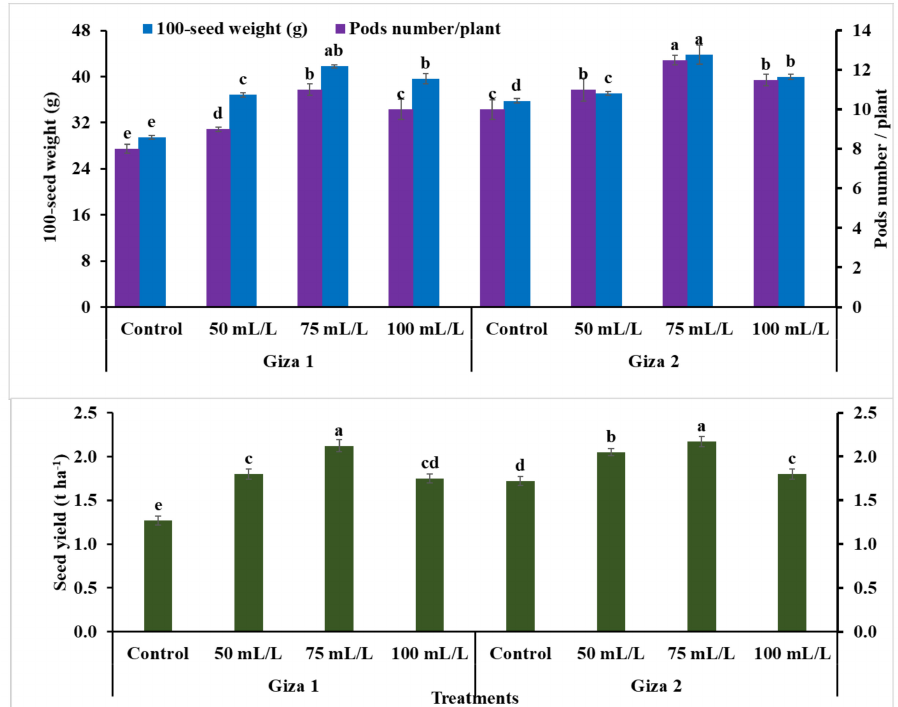
Figure 6. Effect of four AYE exogenous applications on 100-seed weight and pods number per plant (upper graph), and seed yield per ha (lower graph) of two lupine cultivars grown in reclaimed-saline soil. For each parameter, treatments followed by the same letter are not significantly differed at p ≤ 0.05. Error bars are ± Standard Error